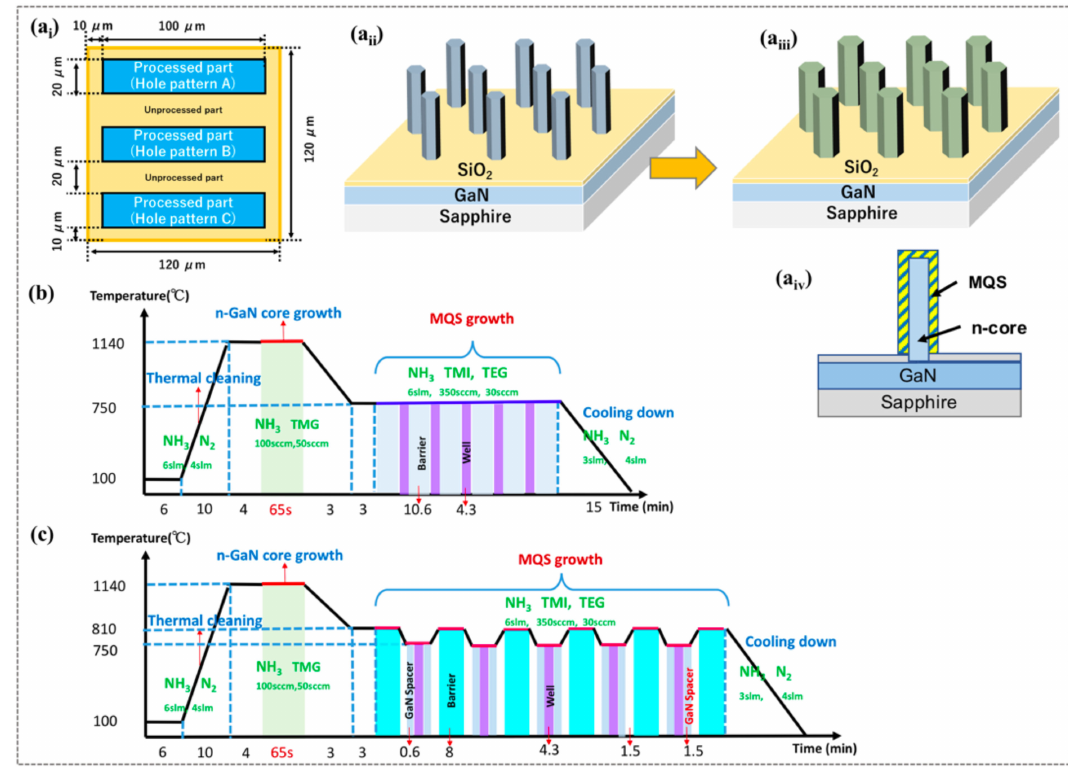
Figure 1. Schematics of ( a i ) the designed template with three aperture array patterns; ( a ii ) the n-GaN core; ( a iii ) the coaxially aligned GaInN / GaN multiple quantum shell (MQS) nanowires (NWs); and ( a iv ) cross section of a GaInN / GaN MQS NW. Schematics of the NW growth conditions at di ff erent barrier growth temperatures: ( b ) 750 ◦ C and ( c ) 800 ◦ C. The durations of each step are labelled in the horizontal